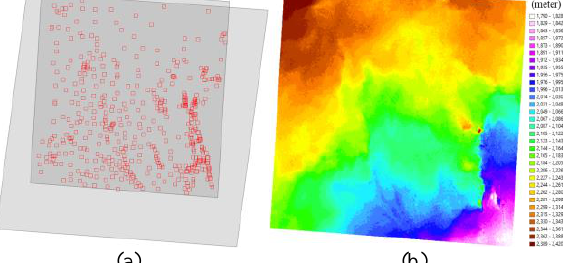
Figure 3. Distribution of tie points and produced DEM. (a) Over 400 manual tie points (red box) with high accuracy are selected with uniform distribution. (b) The produced ASTER DEM displayed here is implemented with registration. The DEM is in the Antarctic Polar Stereographic projection with a true-scale at 71° S based on the WGS 84 ellipsoid